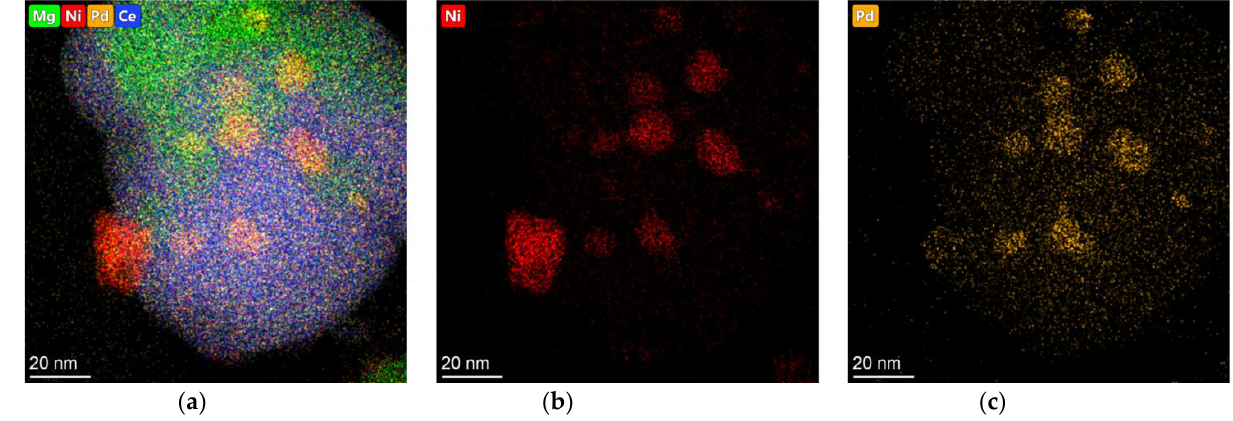
Figure 11. EDX mapping of the ( a ) spent Ni-Pd/CeMg-A-S-V, ( b ) Ni elemental map, ( c ) Pd elemental map.